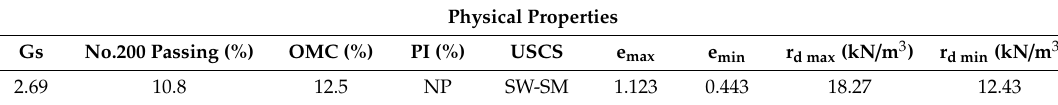
Table 1. Physical properties of soil to be tested.